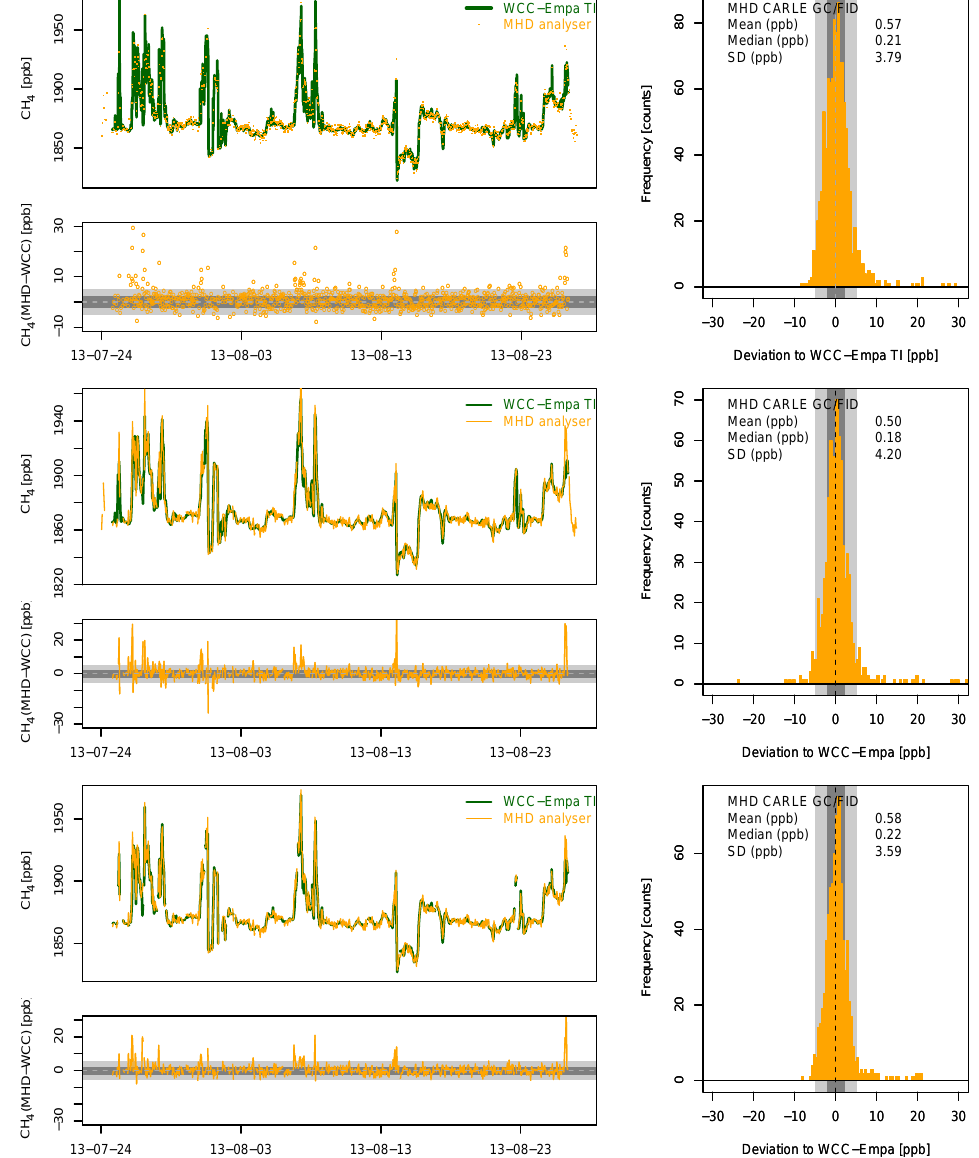
Figure 12. CH 4 comparison at MHD between the WCC-Empa travelling instrument and the MHD CARLE GC/FID instruments. Left: CH 4 time series and CH 4 bias vs time. Right: deviation histogram. Upper set: 1min/single injection data; middle set: 1h data, calculated from all available 1min and single injection values; lower set: 1h data, calculated from 1min and single injection values with both MHD and WCC-Empa data coverage. The grey areas correspond to the WMO/GAW compatibility (dark grey) and extended compatibility (light grey)